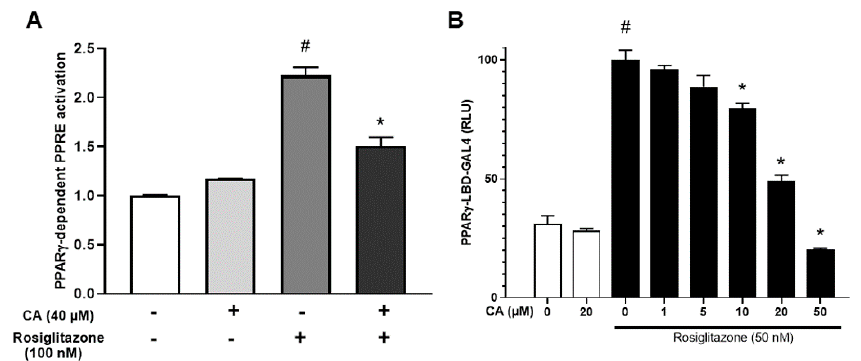
Figure 4. CA antagonizes rosiglitazone-induced activation of PPAR γ . ( A ) HEK293 cells were transfected with PPRE-driven firefly luciferase and SV40-driven Renilla luciferase encoding vectors together with the PPAR γ expression vector. Cells were then incubated in the presence of 100 nM rosiglitazone with or without 40 µM CA. PPRE promoter activity was calculated as the ratio of firefly/Renilla luciferase and expressed as fold over the control situation. ( B ) Concentration-dependent PPAR γ transactivation activities of rosiglitazone were measured in the presence of varying amounts of CA using a PPAR γ -LBD-GAL4 chimera assay. Values are expressed as % of the maximal response measured with rosiglitazone (50 nM). Data are displayed as mean ± SEM of two to three independent experiments (three replicates for each experiments). Student test, p < 0.05 was considered significant: #, rosiglitazone conditions vs. control; *, CA conditions vs. untreated.